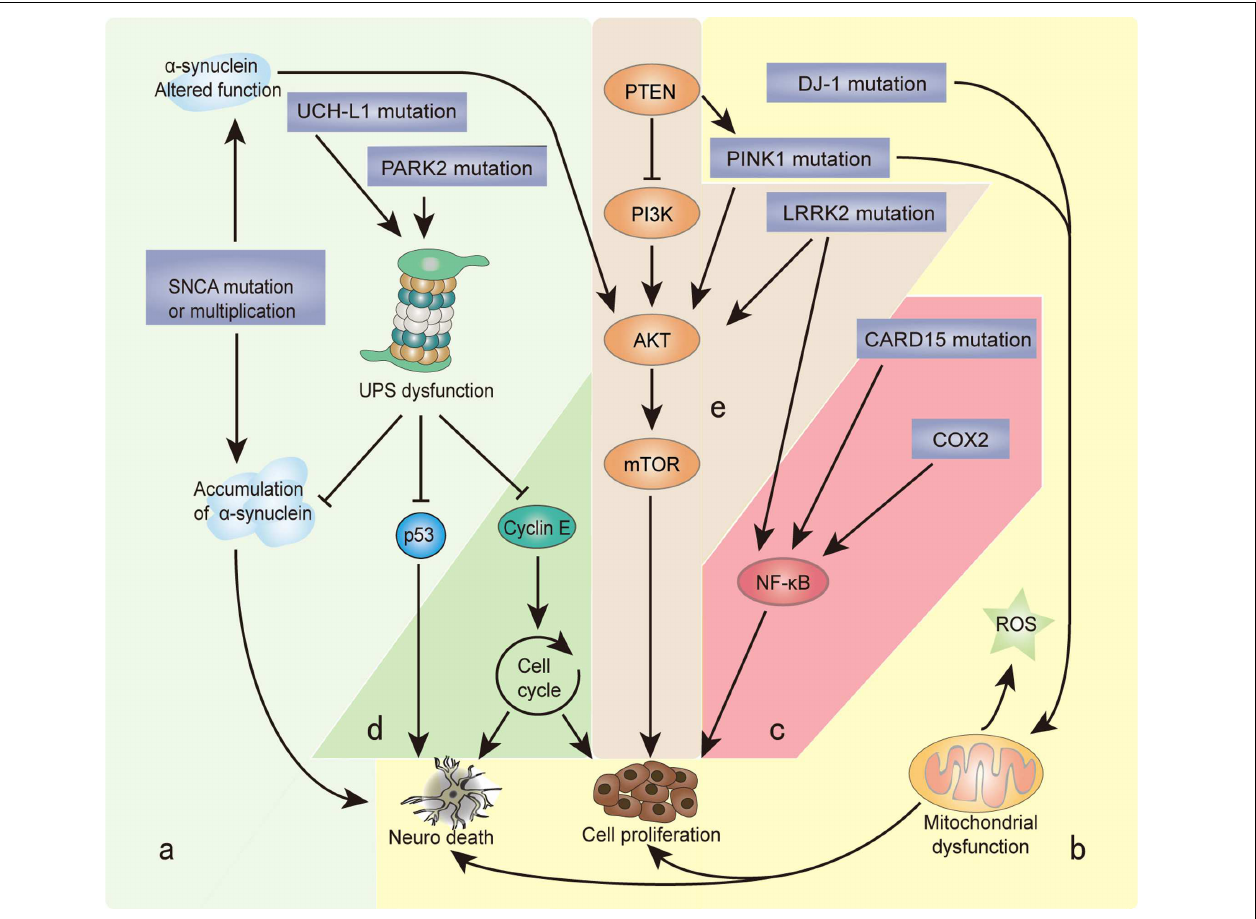
FIGURE 1 | Genes and biological processes shared in Parkinson’s disease (PD) and cancer. Overlapping biological processes of PD and cancer mainly include the following: (a) misfolding and degradation of proteins, (b) mitochondrial damage and oxidative stress response, (c) chronic inflammation, (d) cell cycle control and DNA repair, and (e) PI3K/AKT/mTOR pathway regulation. The α -synuclein polymer attributed to SNCA multiplication is the main component of Lewy bodies (LBs). SNCA mutations alter the normal function of α -synuclein, which induces the PI3K/AKT/mTOR pathway and promotes cell proliferation. Under the cascade of phosphorylating AKT, mTOR is activated by PINK1 and LRRK2. PARK2 and UCH-L1 mutations disrupt the degradation function of the ubiquitin proteasome system (UPS), leading to the misfolding and aggregation of α -synuclein, cyclin E, and p53. PINK1 and DJ-1 mutations result in the overproduction of free radicals and oxidative stress in the mitochondria, which causes neuron defects and stimulates cell proliferation. COX2 and CARD15 mutations activate the NF- κ B pathway and induce chronic inflammation, leading to a wide range of genetic mutations and abnormal cellular signaling. The different cellular backgrounds of cancer cells and neurons (mitotic vs. post-mitotic cells) bring completely distinct reactions to external stimuli and internal changes: some undergo cell proliferation, and others neuron death. The final result is two serious diseases: cancer and